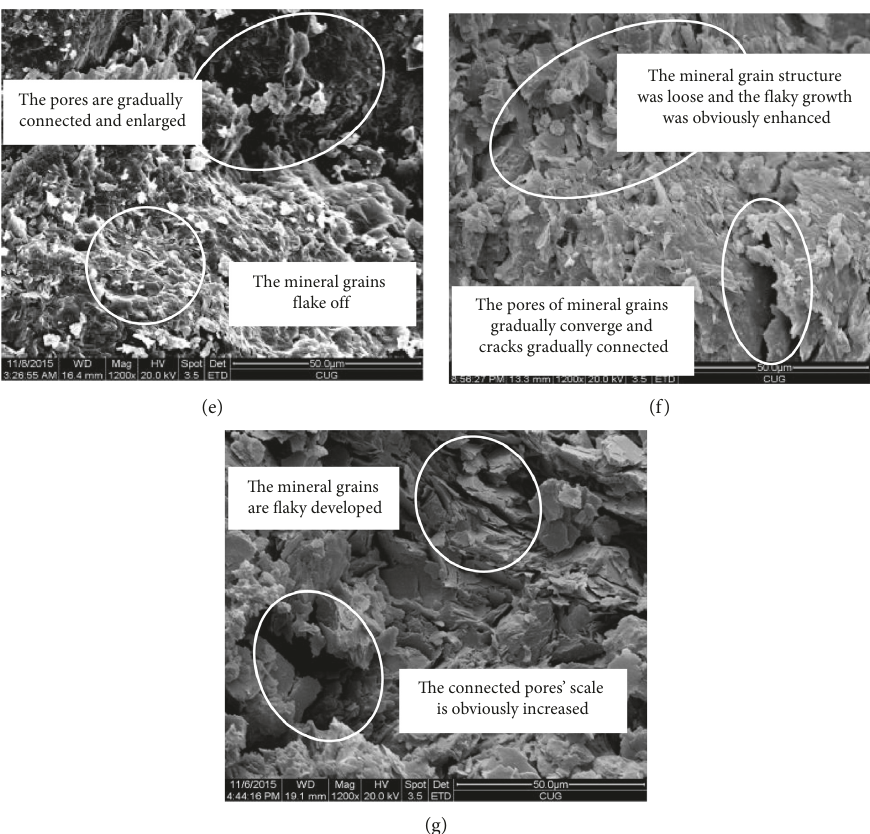
Figure 12: Microstructure characteristics of rock samples under the water-rock interaction ( × 1200). (a) The original state. (b) The first period. (c) The second period. (d) The fourth period. (e) The sixth period. (f) The eighth period. (g) The tenth